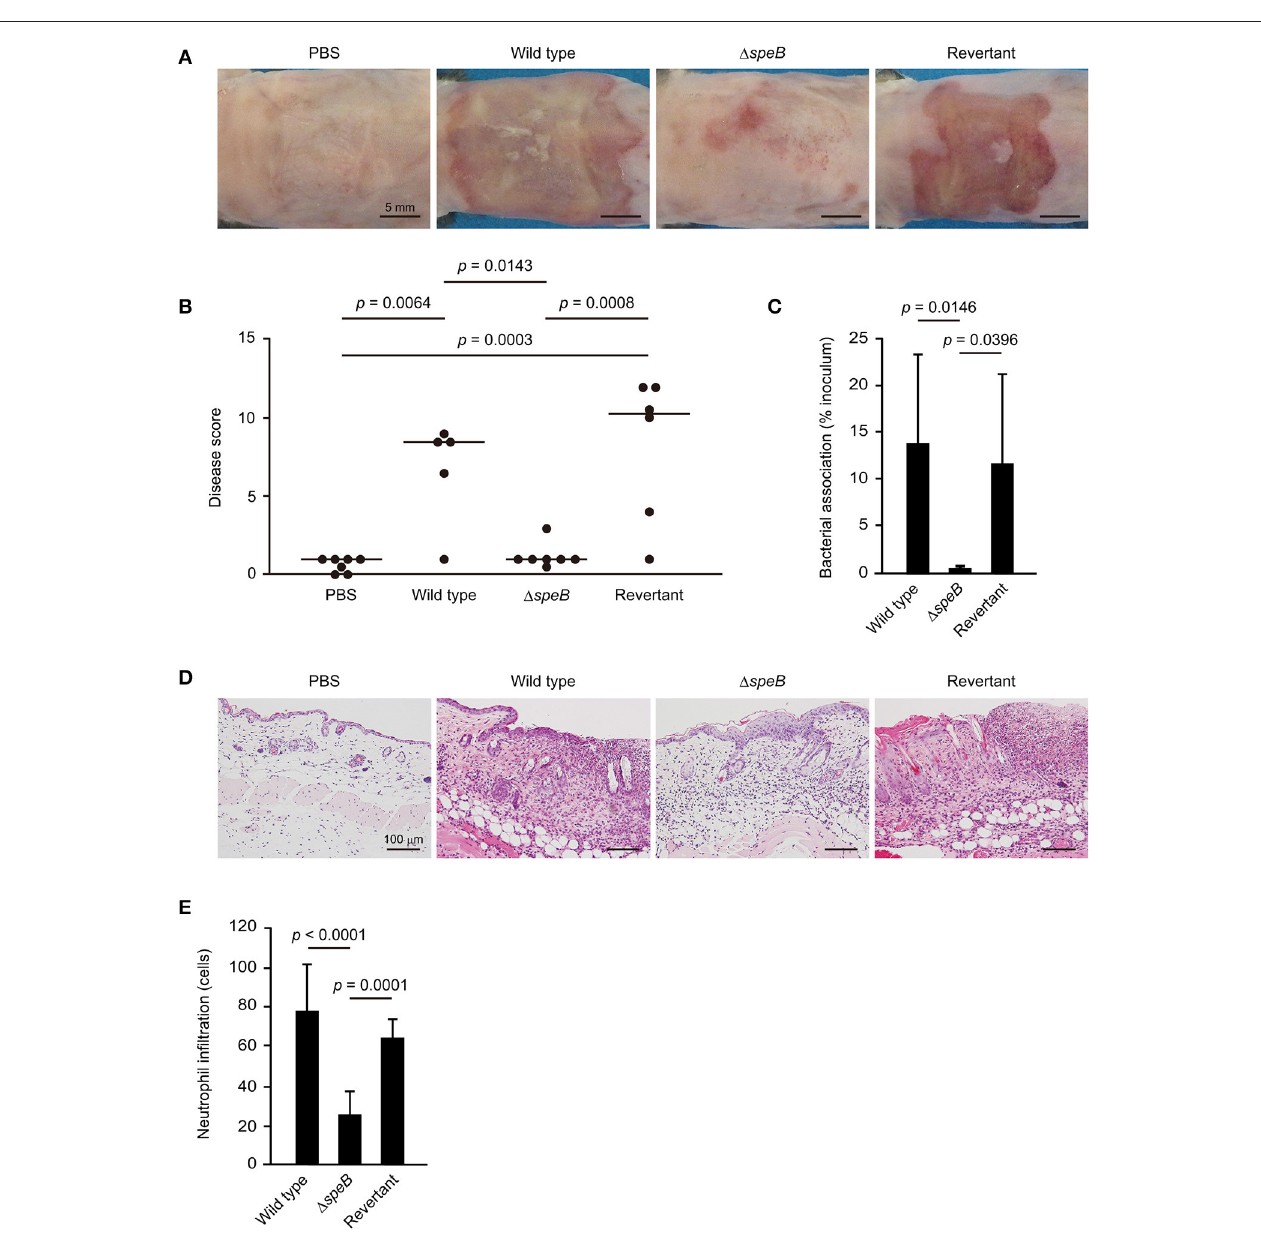
FIGURE 3 | SpeB is critical for the development of cutaneous lesions. Mice were infected in an epicutaneous manner with strain 591, the speB deletion mutant, or the revertant strain for 3 days. (A) Representative gross appearance of mouse skin samples after infection with the S. pyogenes strains. (B) Cutaneous disease score was determined as the sum of individual scores for erythema, edema, erosion, and purulence, graded as follows: 0 (none), 1 (mild), 2 (moderate), and 3 (severe). The median value for each group is shown as a horizontal bar. (C) Each cutaneous tissue homogenate was serially diluted and plated on a THY agar plate containing 5% sheep blood. Data shown represent the mean ± S.D. of quintuplet samples and are representative of at least three independent experiments. (D) Cutaneous tissues from infection sites were stained with hematoxylin and eosin. Data shown are representative of at least three separate experiments. (E) Cutaneous inflammation was evaluated based on neutrophil infiltration into the epidermis and dermis. Data were obtained from five random fields of view (x400) and are presented as the mean ± S.D. of 9 independent samples. Statistically significant differences were evaluated using one-way ANOVA, followed by Tukey’s multiple comparison